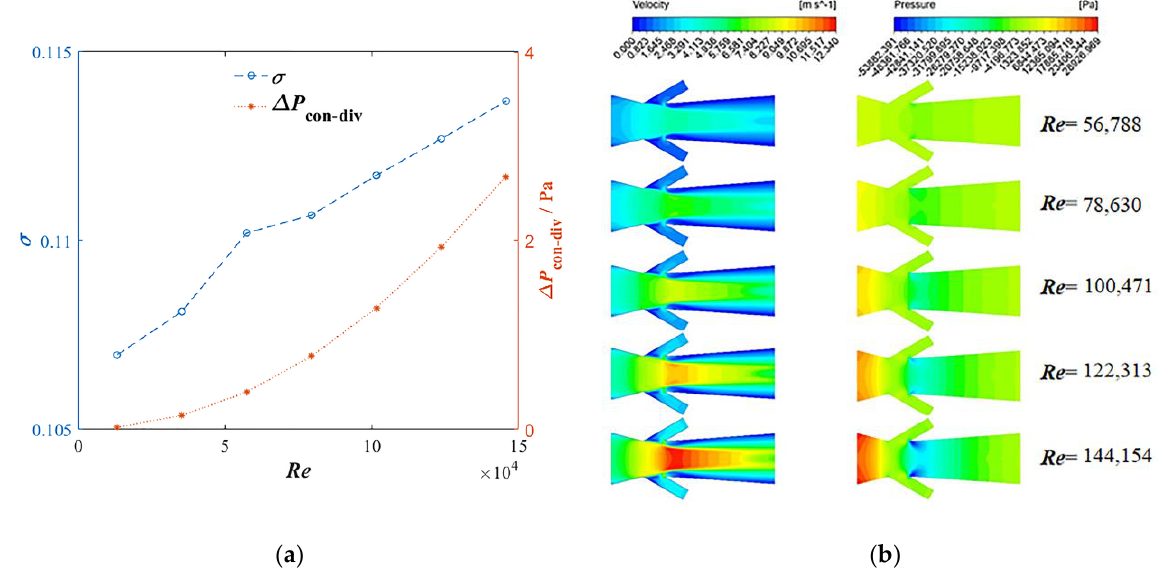
Figure 18. The effects of motive flow Reynolds number on ( a ) ∆ P con-div and σ , ( b ) velocity and pressure distributions in VTM.